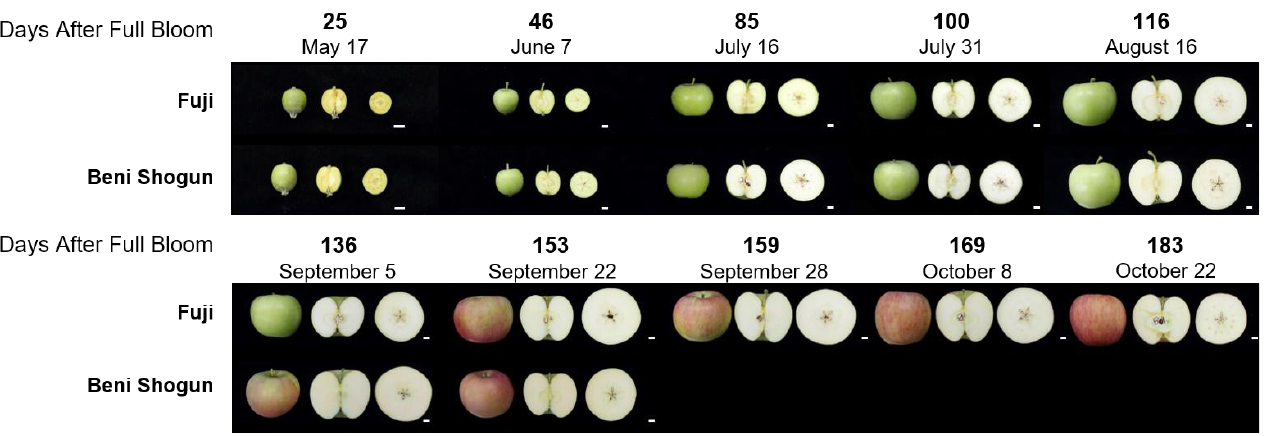
Figure 1. Surface and cross-sectional images of fruit at ten developmental stages. ‘Fuji’ and ‘Beni Shogun’ apples were harvested, periodically after full bloom (DAFB), at days 25, 46, 85, 100, 116, 136, 153, 159, 169, and 183 from trees grown at the Apple Research Institute in Gunwi, Republic of Korea. The full bloom date was 23 April 2018. The last developmental stage is the commercial harvest period for each cultivar. Bars represent 1 cm.